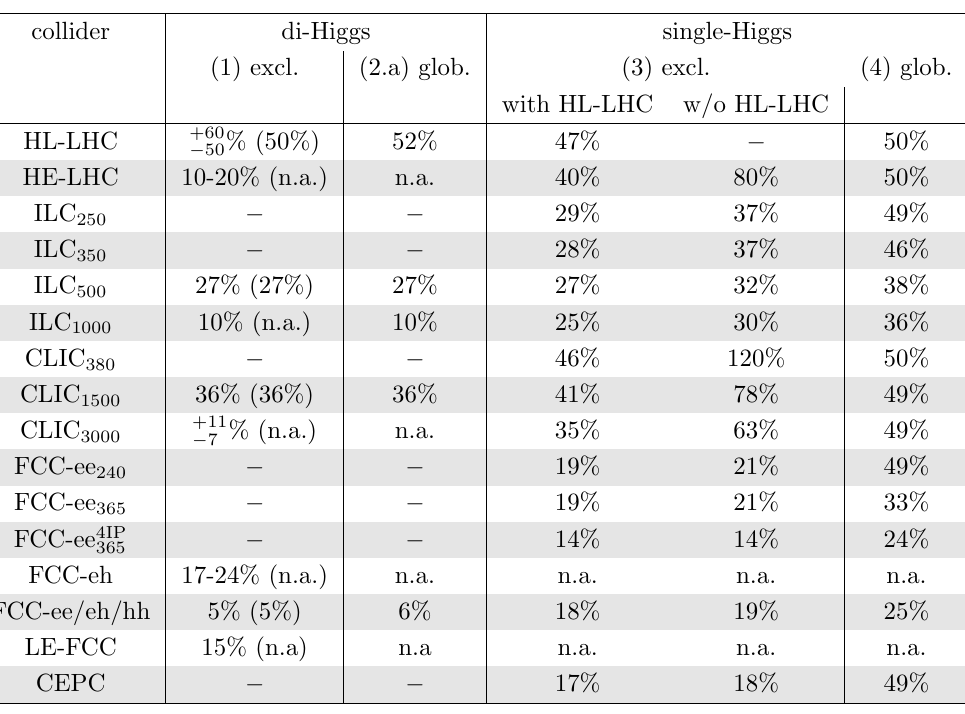
Table 12 . Sensitivity at 68% probability on the Higgs cubic self-coupling at the various future colliders. All the numbers reported correspond to a simpli(cid:12)ed combination of the considered collider with HL-LHC, which is approximated by a 50% constraint on (cid:20) 3 . The numbers in the (cid:12)rst column (i.e. \di-H excl." or Method (1)) correspond to the results given by the future collider collaborations and in parenthesis, we report our derived estimate obtained in the binned analysis described in the text. In the three last columns, i.e. Methods (2a), (3) and (4), we report the results computed by the Higgs@FC working group. For the leptonic colliders, the runs are considered in sequence. For p the colliders with s . 400 GeV, Methods (1) and (2.a) cannot be used, hence the dash signs in the corresponding cells. No sensitivity was computed along Method (2.a) for HE-LHC and CLIC 3000 but our initial checks do not show any di(cid:11)erence with the sensitivity obtained for Method (1). In the global analyses, Methods (2.a) and (4), we consider the (cid:13)avour scenario of Neutral Diagonality (the results show little di(cid:11)erence compared to the ones reported in the (cid:12)rst version of this report within the Neutral Diagonality scenario). Due to the lack of results available for the ep cross section in SMEFT, we do not present any result for LHeC nor HE-LHeC, and only results with Method (1) for FCC-eh. For Method (3) results are shown with and without combination with HL-LHC